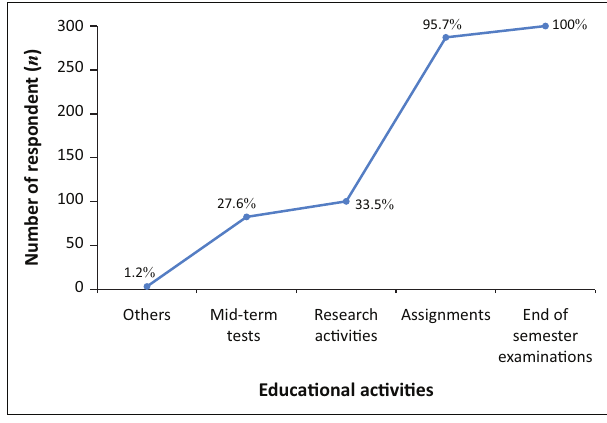
FIGURE 2: Kinds of educational activities accomplished using the needed information ( n =